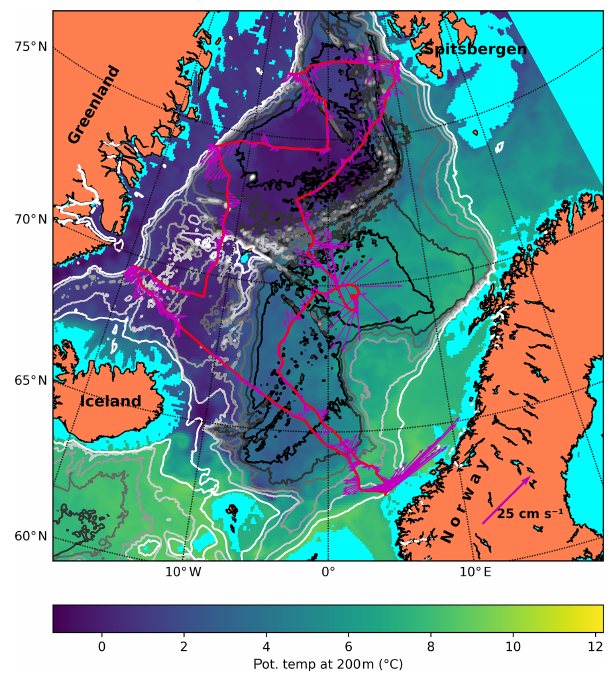
Figure 4. Slow glider mission in the Nordic Seas. The glider mission starts at the south-eastern corner, off Norway at 62.8 ◦ N 4.25 ◦ E at the 500m isobath, and returns 1.5 years later. The glider track proceeds anticlockwise. Bathymetric contours are drawn at 500m intervals. Arrows indicate depth-averaged currents measured or experienced by the glider (e.g. Rudnick et al., 2018). The tem- perature at 200m is also shown to indicate water mass distribution: T > 4 ◦ C is typically Atlantic water with S > 35. Note that the tem- perature at 200m introduces an implicit isobath at 200m, leaving shelves in a light blue